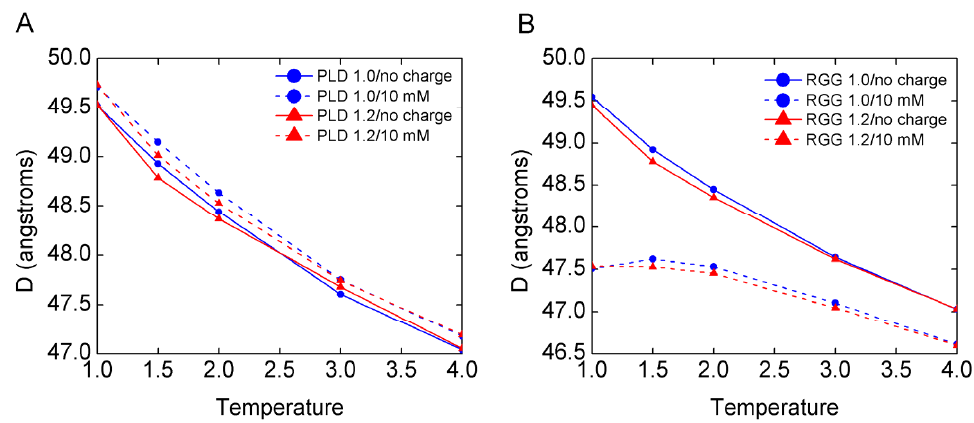
Figure 8. Head-to-tail distance (D) of PLD ( A ) and RGG ( B ) chains with bead mass 1.0 and 1.2 as a function of temperature. The D value is calculated by the mean value of the 200 chains in the system during the last 1000 τ simulation data.